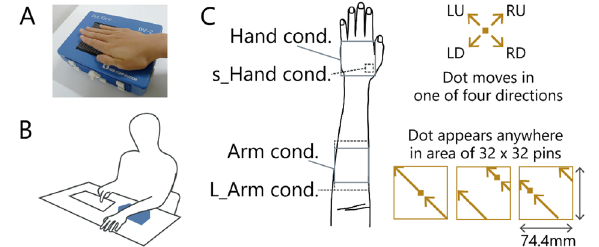
Figure 1. ( A ) Braille-type stimulator. ( B ) View of the setup used in the experiments. The blue box represents the braille stimulator. The participants’ view was blocked by an occluder (not illustrated) and the stimuli were not visible. ( C ) The participants reported the perceived direction of the stimulus trajectory by pressing two arrow keys (e.g., ‘up’ and ‘left’ for the illustrated LU stimuli at the bottom of the